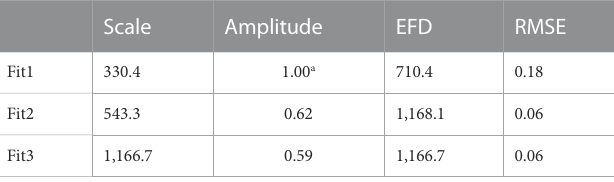
TABLE 4 The scale parameter ( α − 1 ), amplitude A ), effective e-folding distance (EFD), and root-mean-square error (RSME) for three fi ts to vertical daily snow depth increment correlations. All units are m except for the dimensionless